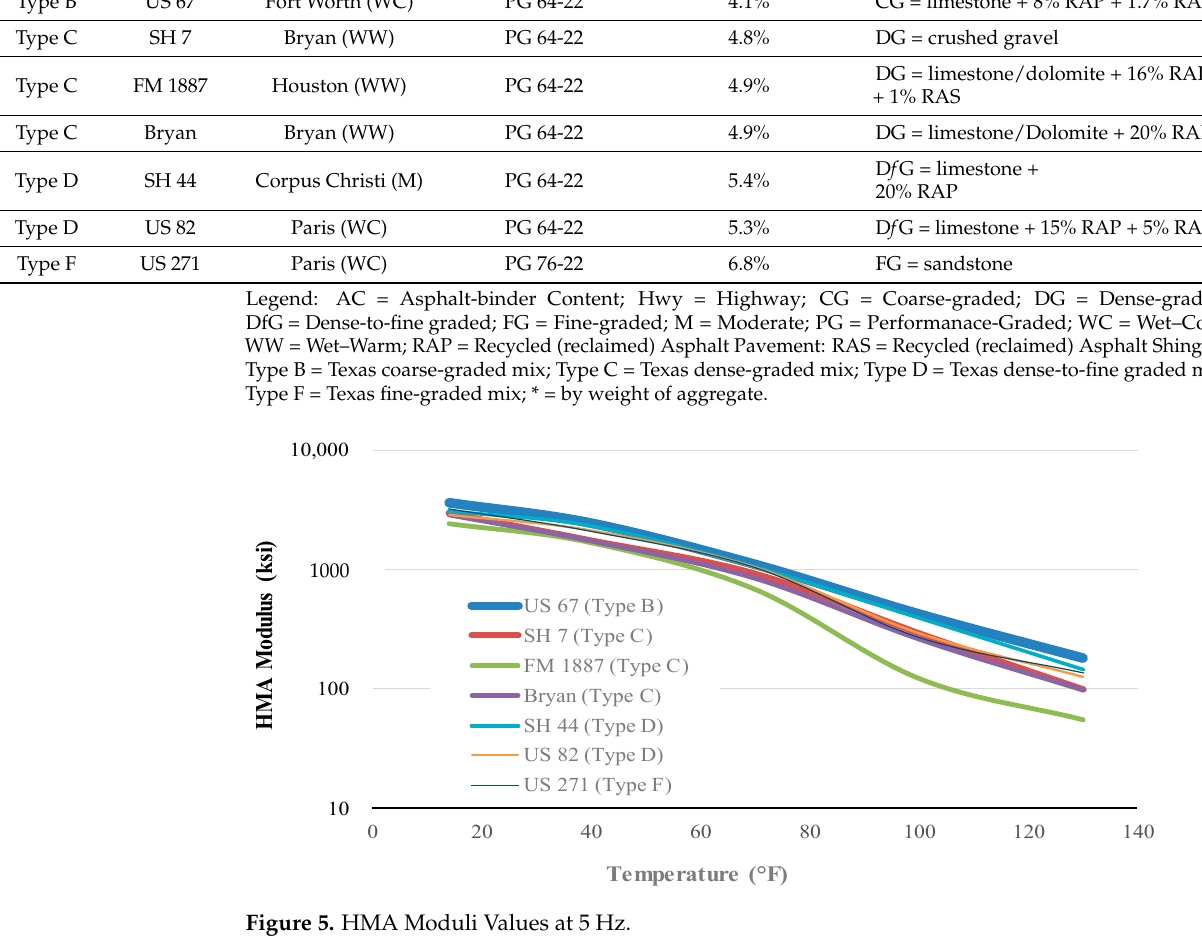
Figure 6. HWTT-HiSEC Energy Generation—HMA Variation (1 Hz and 20 °C). Figure 5 shows no significant effect of mix type variation and gradation on the energy generation potential of the HiSEC module and PZT sensors at 20 °C with 50 mm top HMA cover. Due to the rigidity and stiffness (i.e., high modulus values) of the HMA mixes at the 20 °C testing temperature, an almost identical transfer of the applied wheel load onto the module is achieved irrespective of the asphalt (HMA) mix type. As a result of the applied stress being transferred almost equally using different HMA types, mix-designs, volumetrics, and gradations, one can infer that the HMA properties at ambient and cold temperatures have no major impact on the HiSEC’s energy generation and power output.